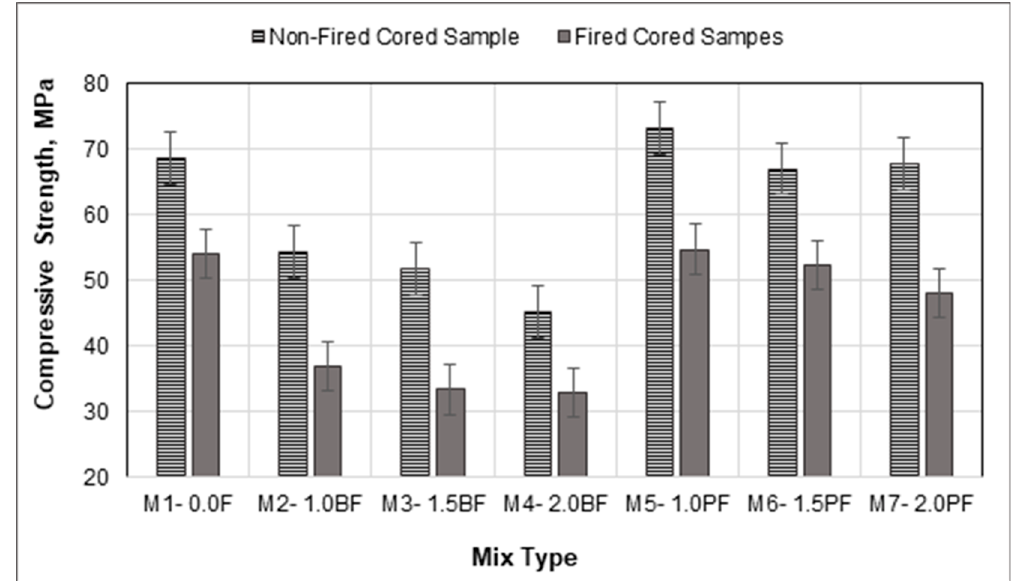
Figure 12. Effects of 120 min of fire exposure on the compressive strength. Figure 12. E ff ects of 120 min of fire exposure on the compressive strength.